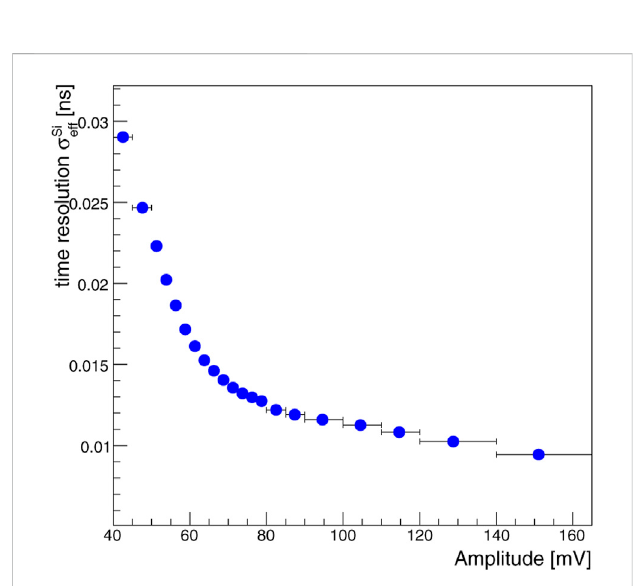
FIGURE 10 Single pixel time resolution as a function of the signal amplitude. The results are obtained from a large data sample where the pixel triggered the acquisition and the bias voltage was V bias = − 75 V. The resolutionvaluescorrespondtothe reference method.Thevalueat 150 mV, σ Si eff (cid:2) 9 . 45 ± 0 . 06 ps represents an upper estimate of the intrinsic time resolution of the